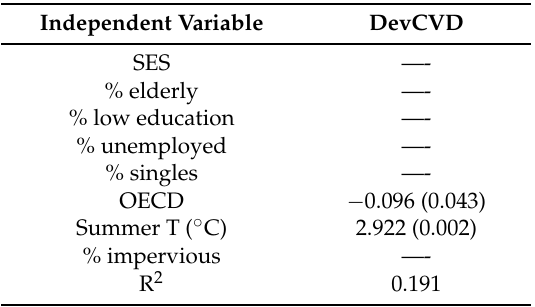
Table 4. Independent variables (see Table 1) chosen by the stepwise regression model as significantly related to the mean relative excess mortality due to CVDs on hot days ( DevCVD ) in individual districts. Regression coefficients are reported, along with their associated p -values in